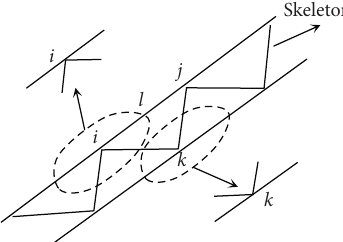
Figure 2: Investigated lumps of skeleton structure.